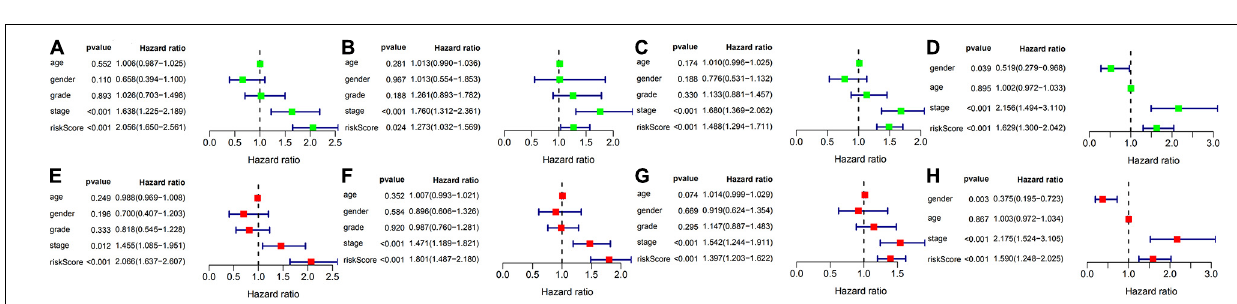
FIGURE 5 | Univariate Cox and Multivariate Cox regression analysis of risk score and clinicopathologic factors in different cohorts. (A–D) Forest plot represents the results of univariate Cox regression analysis in the training set, test set, TCGA set and ICGC set, respectively. (E–H) Forest plot represents the results of multivariate Cox regression analysis in the training set, test set, TCGA set and ICGC set,